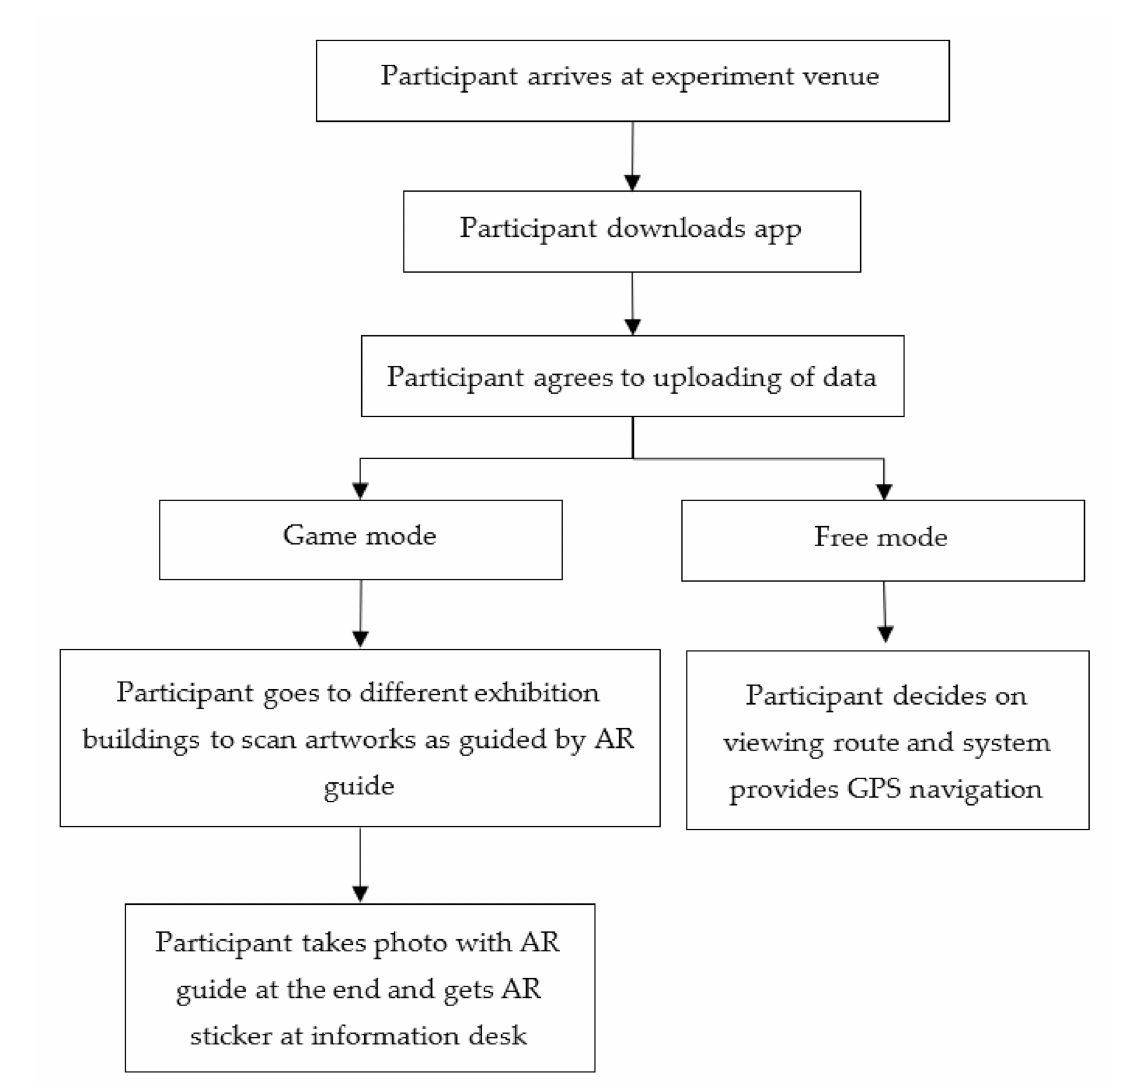
Figure 6. Flow chart of experiment